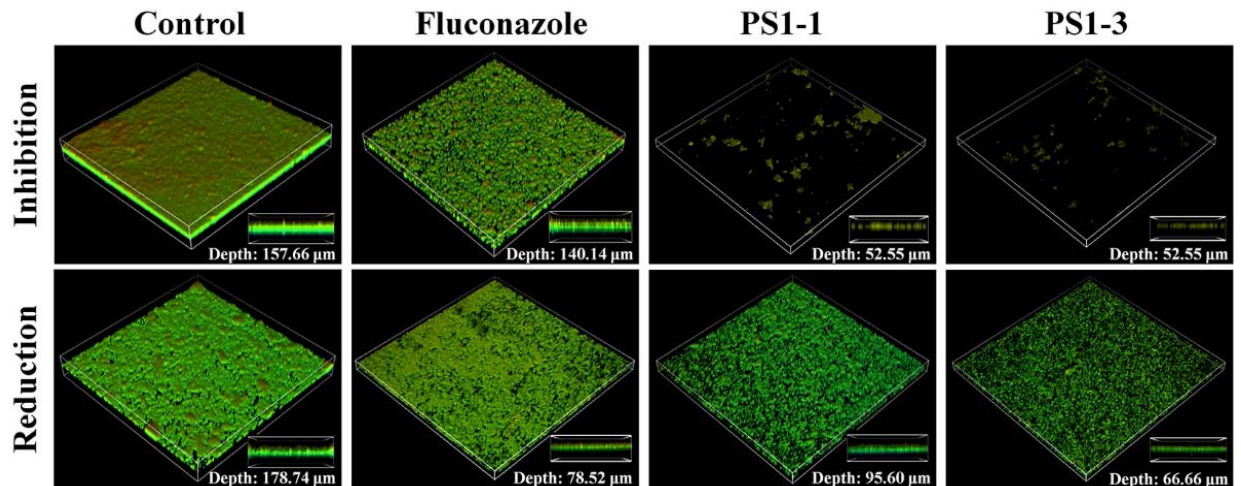
Figure 5. Image analysis of C. albicans CCARM 14007 strain using confocal laser scanning microscopy (CLSM). The biofilm inhibition and reduction on C. albicans CCARM 14007 in the absence (control) or presence of Fluconazole, PS1-1, and PS1-3. Biofilm formation by C. albicans CCARM 14007 was stained using FUN1 dye. All values represent three individual experiments.